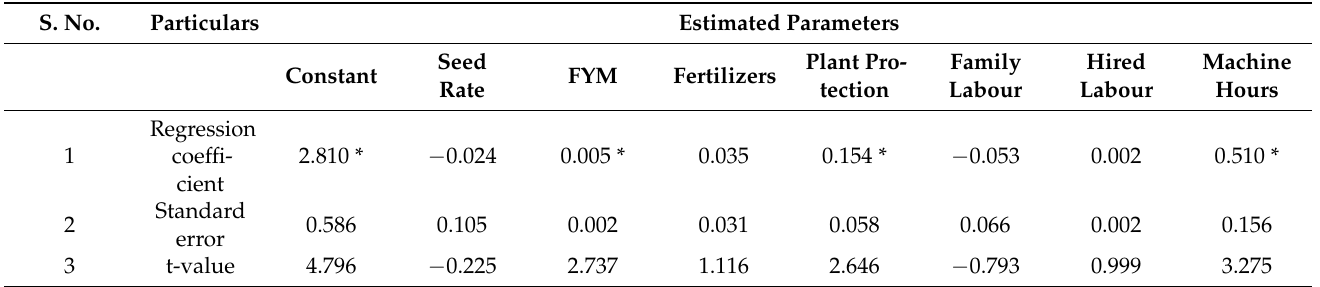
Table 10. Production function estimates of marigold cultivation in Kathua